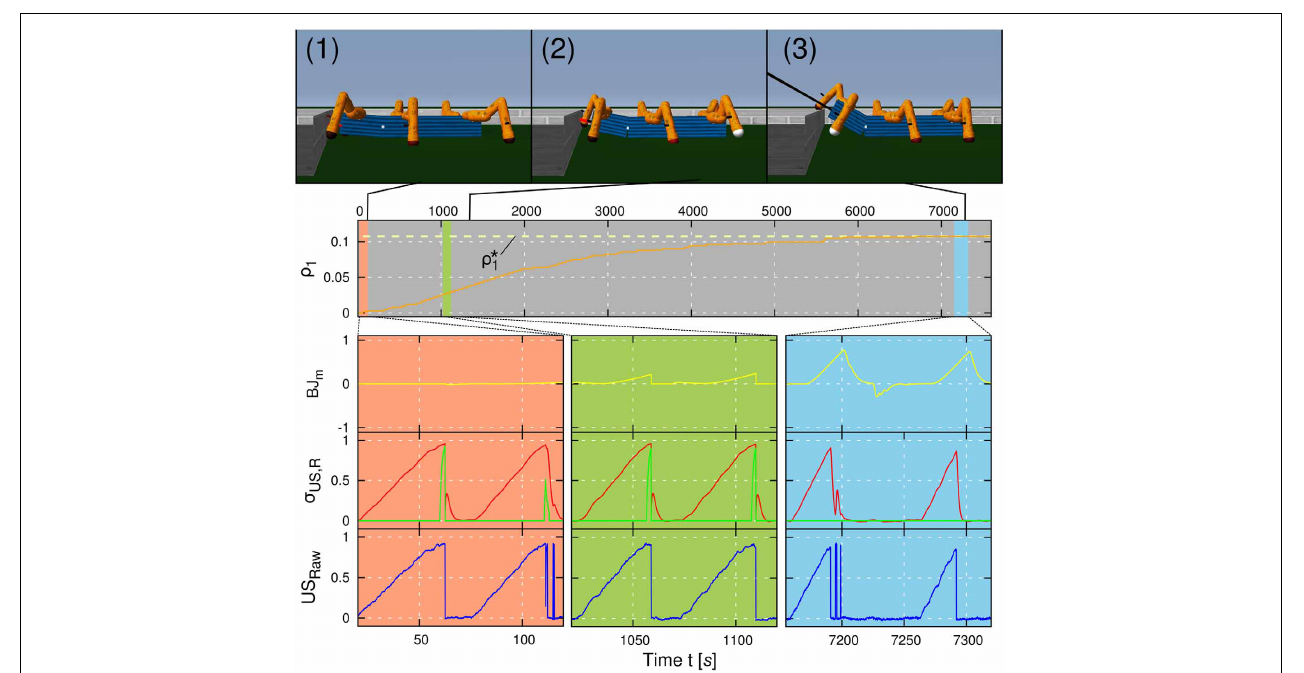
value ρ ∗ 1 (dashed line) for which the robot generates an optimal backbone joint motion, i.e., an optimal leaning behavior (see sky blue colored area, photo 3). The convergence is due to the fact that the reflex signal is avoided such that it does not occur after learning. Raw data ( US raw , blue line) coming from the ultrasonic (US) sensors is also shown. Note that all graphs illustrated in this figure correspond to the right US sensor. The learning curve of signals coming from the left US sensor shows a similar behavior. The learning rate is set to μ = 0 . 01.